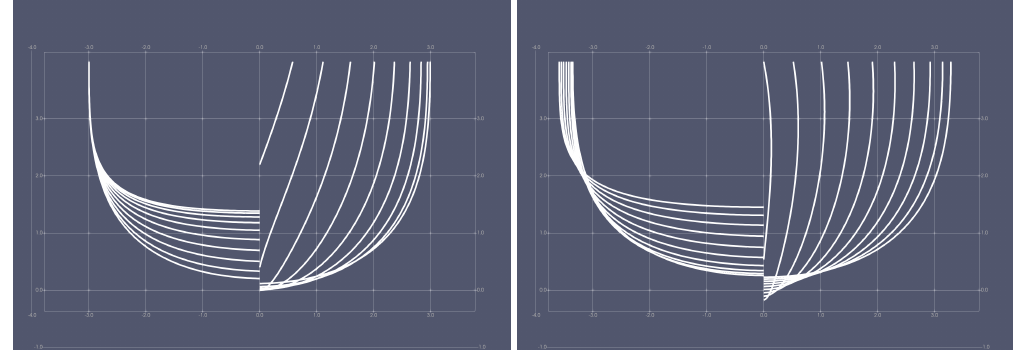
Figure 5. Comparison of the section views for the original ( left ) and the optimal ( right ) hull shapes for the effective power optimization